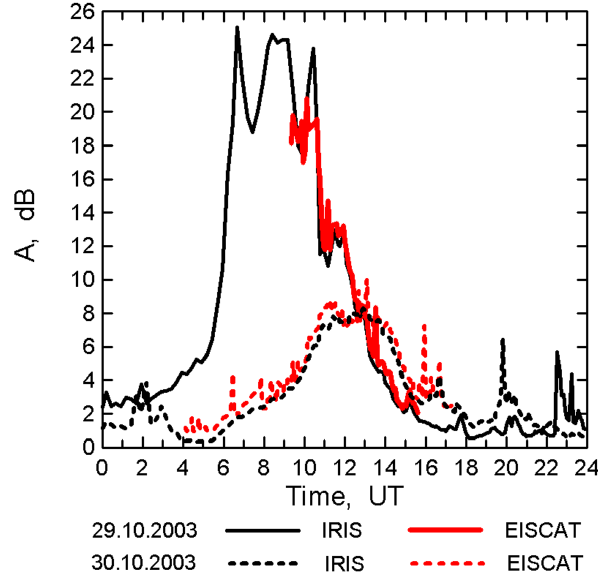
Fig. 8. Comparison of time series of the measured values of cos- mic noise absorption from the IRIS riometer at Kilpisj¨arvi (black curves) with absorption calculated on the basis of experimental (EISCAT) N e -profiles (red curves). The solid lines are on 29 Octo- ber 2003, the dashed lines are on 30 October 2003. Absorption is given for a frequency of